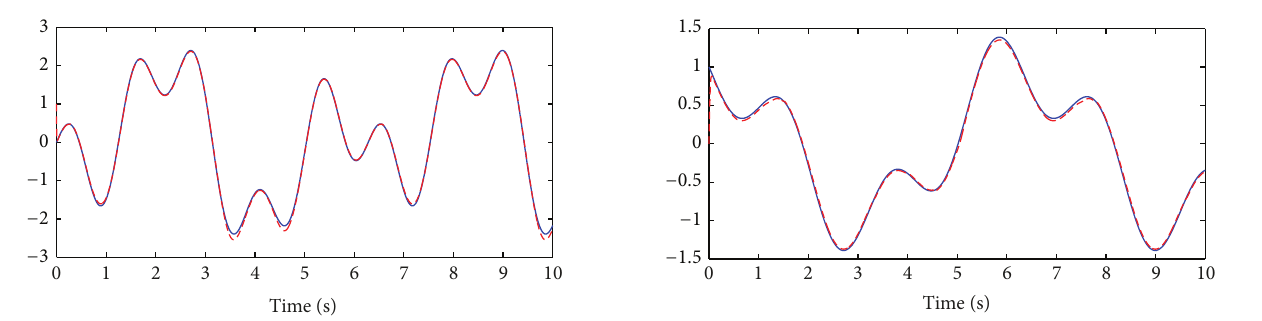
Figure 1: Tracking process: reference trajectory 𝑥 𝑟,1 (𝑡) , solid line; system state 𝑥 1 (𝑡) , dashed line.